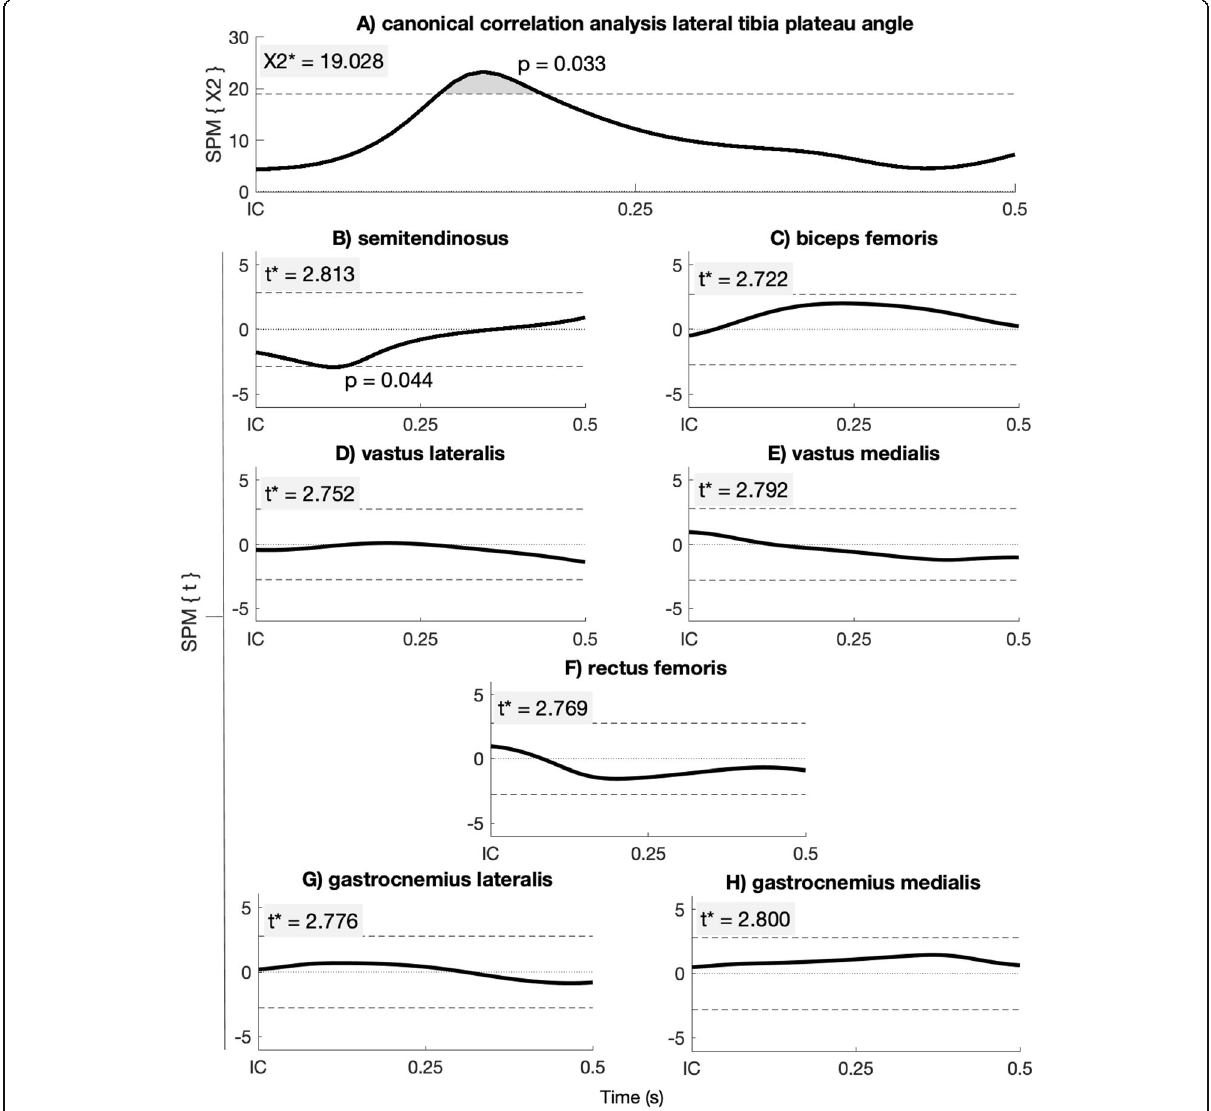
Fig. 4 SPM{X 2 } canonical correlation analysis between muscle activity and the LPTPA ( a ). Pos-hoc SPM{t} regression analysis between LPTPA and the medial hamstrings ( b ), biceps femoris ( c ), vastus lateralis ( d ), vastus medialis ( e ), rectus femoris ( f ), gastrocnemius lateralis ( g ) and gastrocnemius medialis ( h ) activation. X2* and t* are the significant boundaries of the